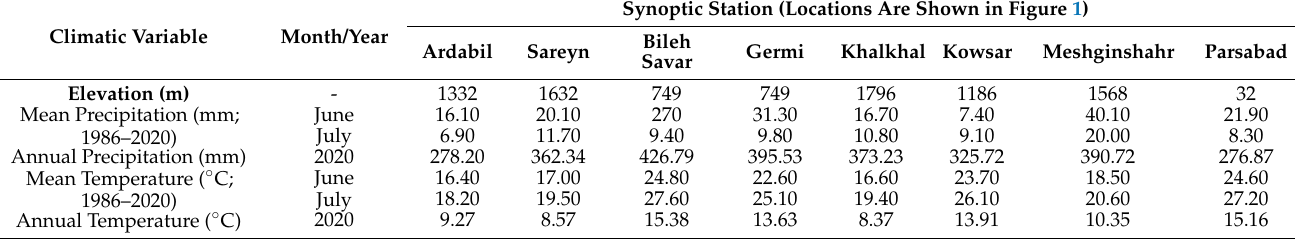
Table 2. Climatic properties of Ardabil Province synoptic